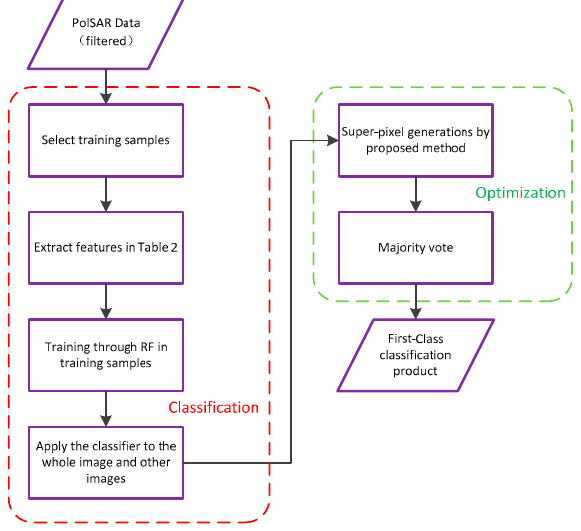
Figure 3. The proposed classification procedure on Chinese Gaofen-3 (GF-3).